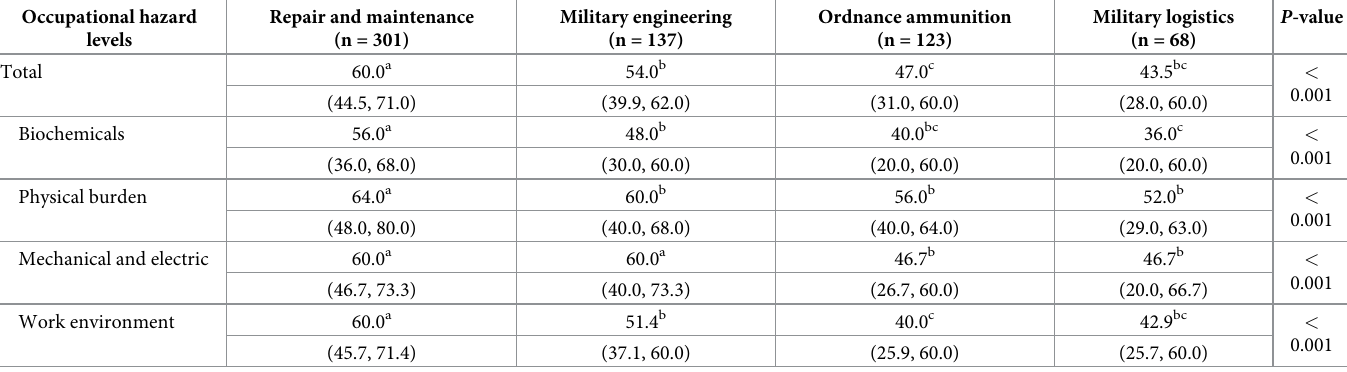
Table 3. Occupational hazard level in four workplace